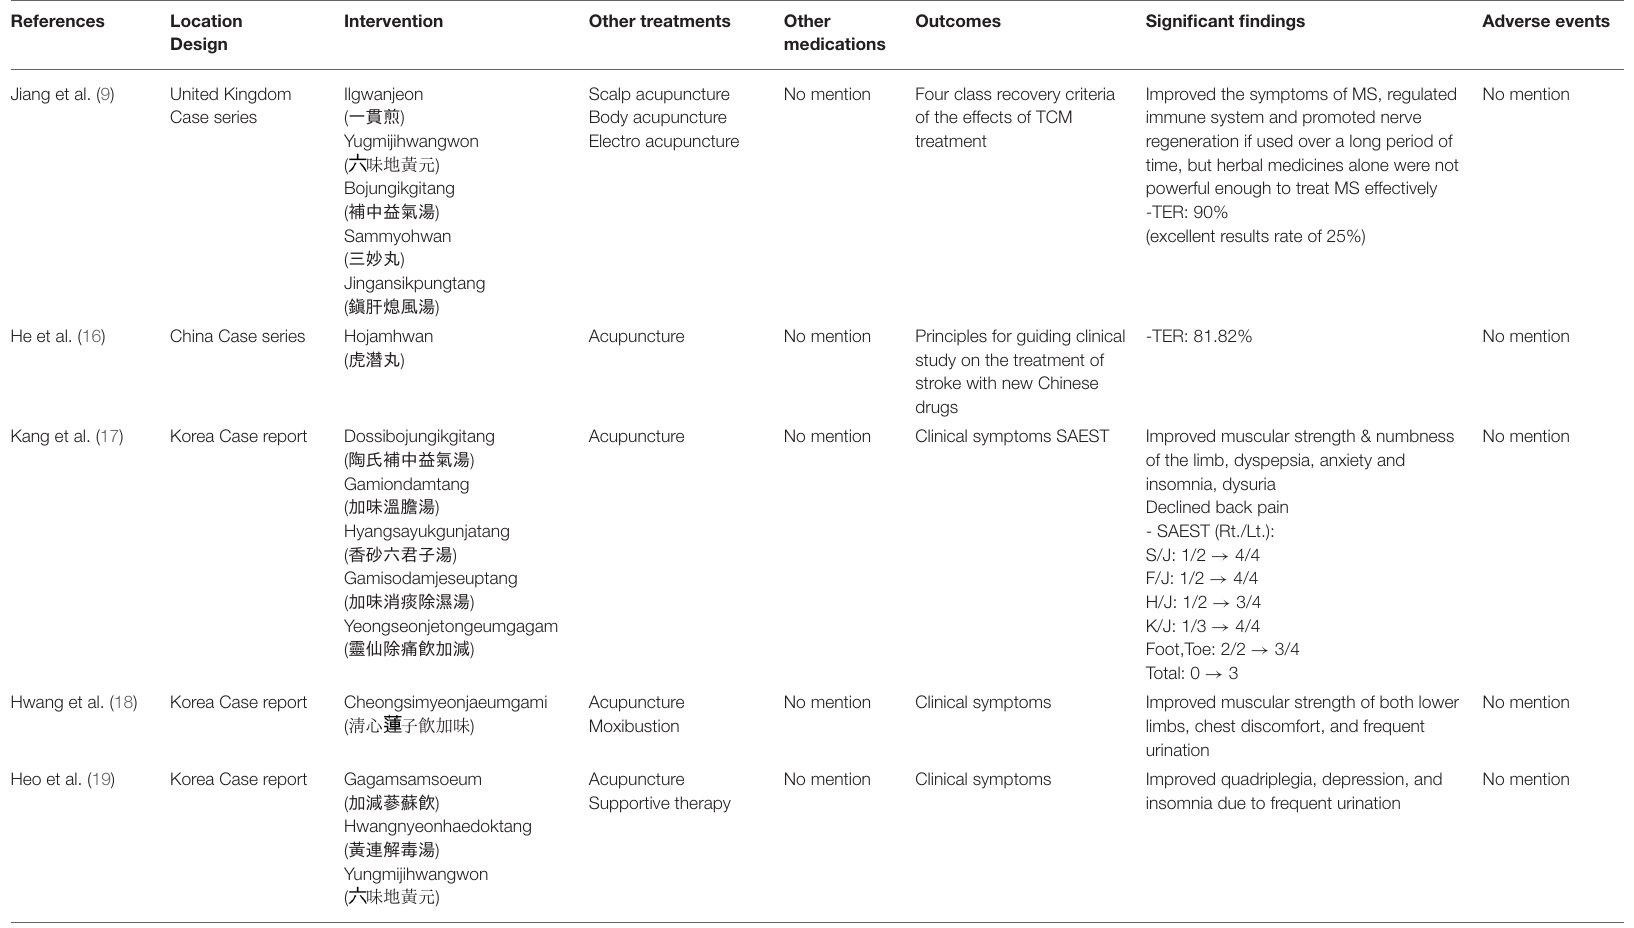
TABLE 3 | Summary of included